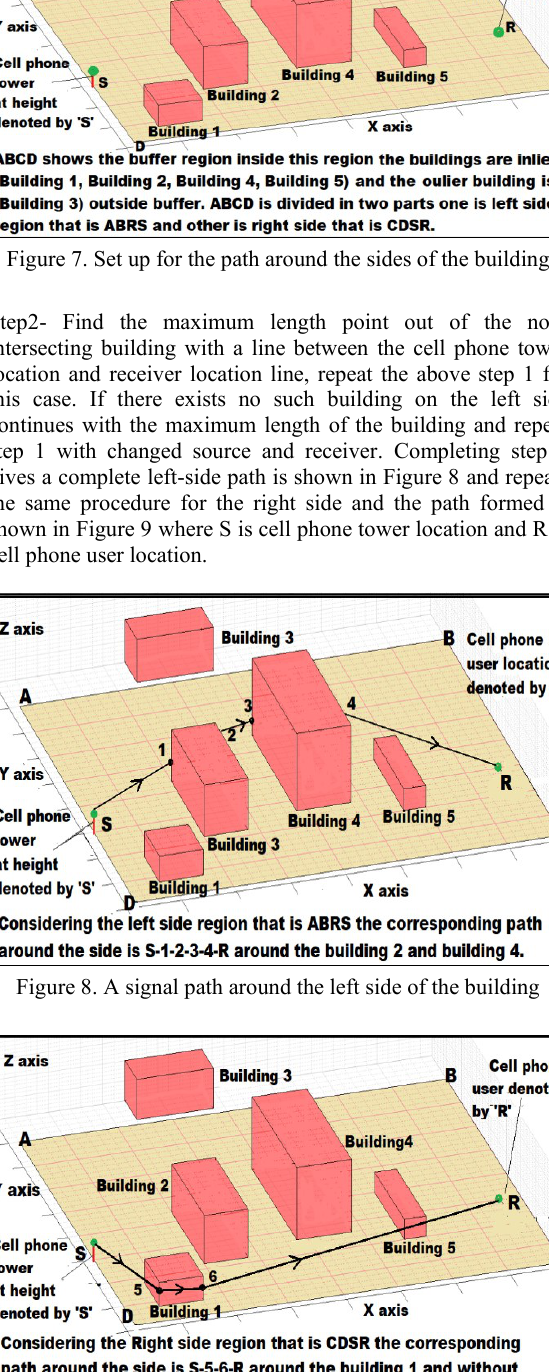
and path around the sides of the building is shown in Figure